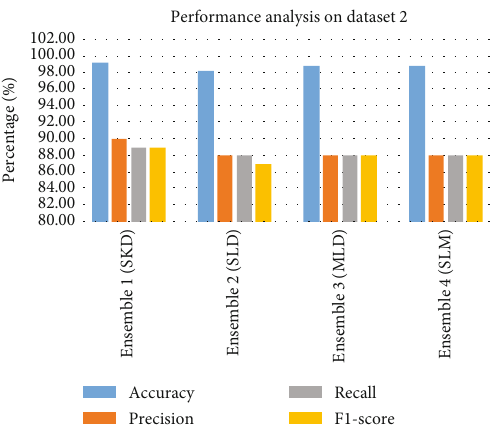
Figure 7: Performance analysis on dataset 2.